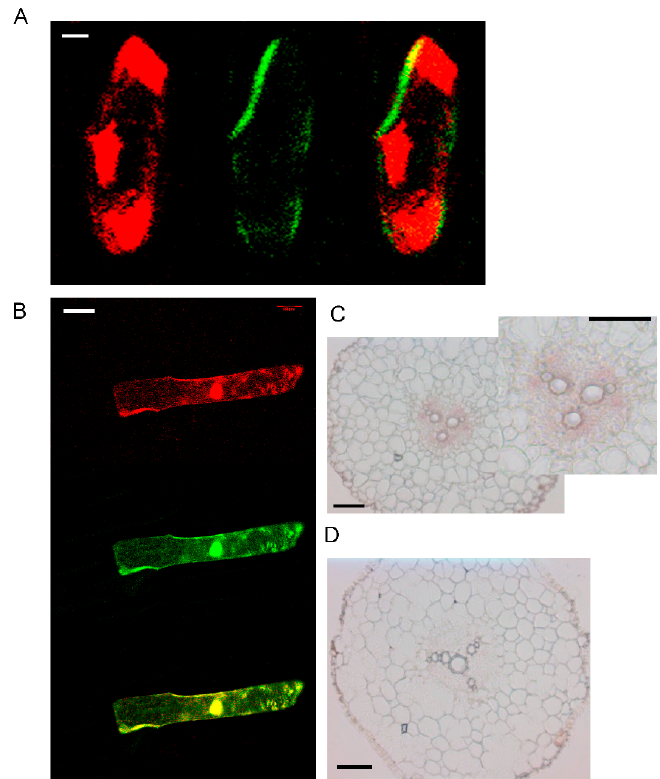
Figure 3. Subcellular and tissue localization of AhYSL3 . 1 . ( A ) 35S-DsRed, as a marker of the cytosol and nucleus, was cointroduced into onion epidermal cells with the AhYSL3 . 1 ORF fused with GFP. Red signals (left panel) are from 35S-DsRed. Green signals (middle panel) are from AhYSL3.1-GFP. Right panel shows a merged image. Scale bars represent 20 μ m. ( B ) GFP alone was colocalized with 35S-DsRed. Scale bars represent 100 μ m. ( C , D ) In situ hybridization analysis of AhYSL3 . 1 in peanut roots. AhYSL3 . 1 antisense ( C ) and sense ( D ) probes were hybridized in a cross section of peanut roots. Bars = 100 μ m.